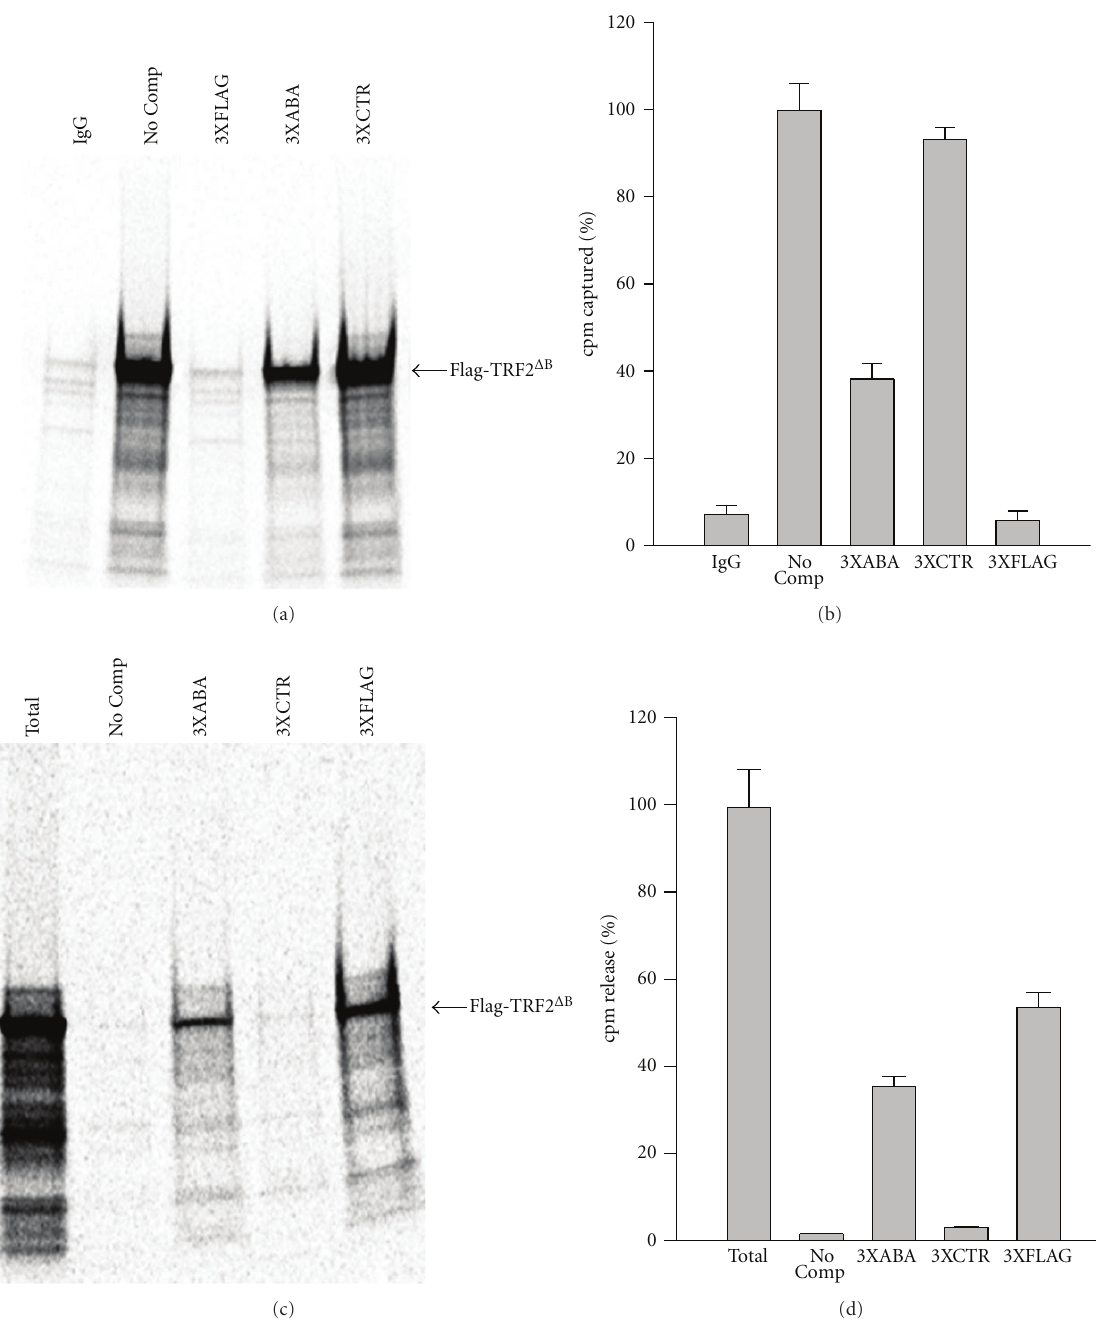
Figure 4: 3XABA oligonucleotide blocks the interaction of Flag-tagged proteins with the M2 antibody. (a)-(b) The 3XABA oligo blocks the binding of Flag-TRF2 Δ B to M2-coated beads. Magnetic beads coated with the M2 antibody were incubated in the absence (No Comp) or presence of the indicated competitor (3XABA, 3XCTR, 3XFLAG). In vitro translated [ 35 S]-labeled Flag-TRF2 Δ B was then added and the amount captured by the beads was determined by SDS-PAGE electrophoresis and exposure to a PhophorImager cassette (a). In a second experiment done in triplicate, the amount of [ 35 S]-labeled protein captured was counted by scintillation (b). The amount of [ 35 S]-labeled protein captured in the absence of competitor (No Comp) was arbitrarily set to 100%. In both experiments, beads coated with normal mouse IgG were included as negative control for the capture (IgG). Data represent the mean ± S.D. ( n = 3). (c)-(d) The 3XABA oligo elutes the Flag-TRF2 Δ B proteins already bound to M2-coated beads. The [ 35 S]-Flag-TRF2 Δ B protein was first captured by magnetic beads coated with the M2 antibody. The beads were then incubated in the absence (No comp) or presence of the indicated competitor (3XABA, 3XCTR, 3XFLAG). The amount of [ 35 S]-Flag-TRF2 Δ B released was determined by SDS-PAGE electrophoresis and exposure to a PhophorImager cassette (c). In a second experiment done in triplicate, the amount of [ 35 S]-labeled protein released was counted by scintillation (d). The amount of [ 35 S]-labeled protein released by the boiling (total) was arbitrarily set to 100%. In both experiments, beads boiled to release to all of the captured [ 35 S]-labeled protein were included as positive control for the elution (Total). Data represent the mean ± S.D. ( n =